Question: What kind of plot is shown here?
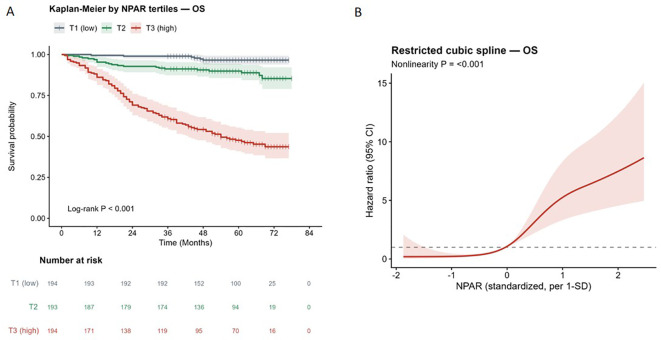
Answer: survival